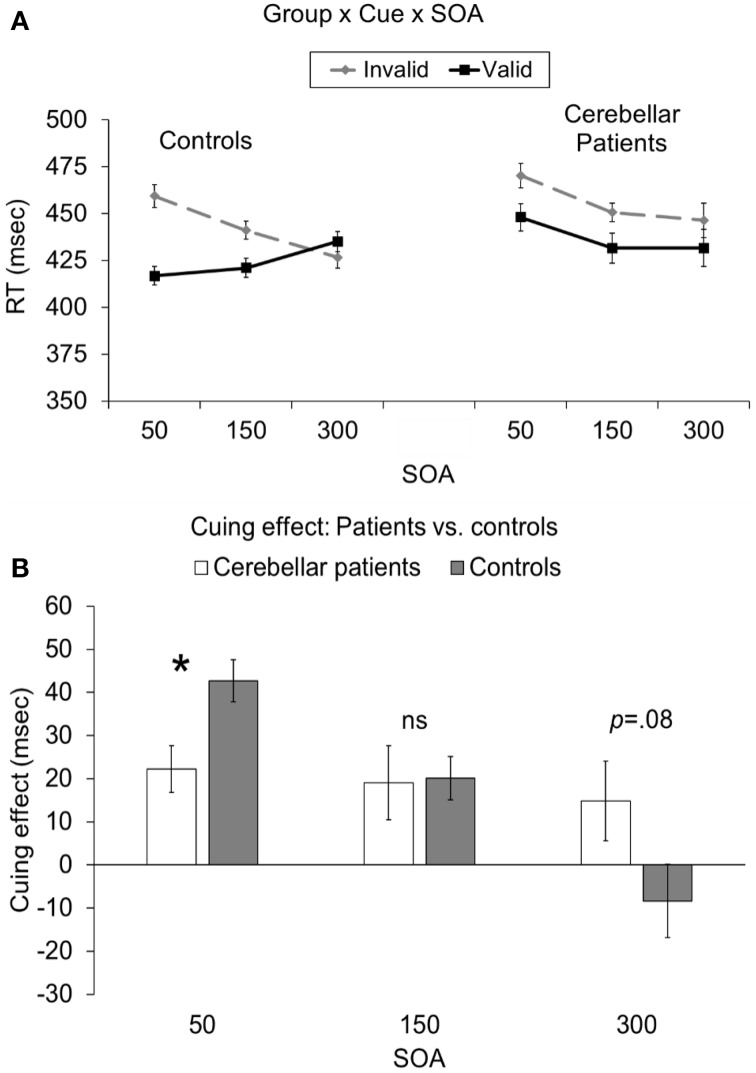
(A) Depicts the group (patients vs. controls) × cue (valid vs. invalid) × SOA (50, 150, 300 ms) interaction. (B) Depicts the cuing effect (invalid RT—valid RT) as a function of group (patients vs. controls) and SOA (50, 150, 300). In both graphs the error bars represent the within-subject standard error (Loftus and Masson, 1994). Statistically significant differences are denoted by *p < 0.05, corrected.